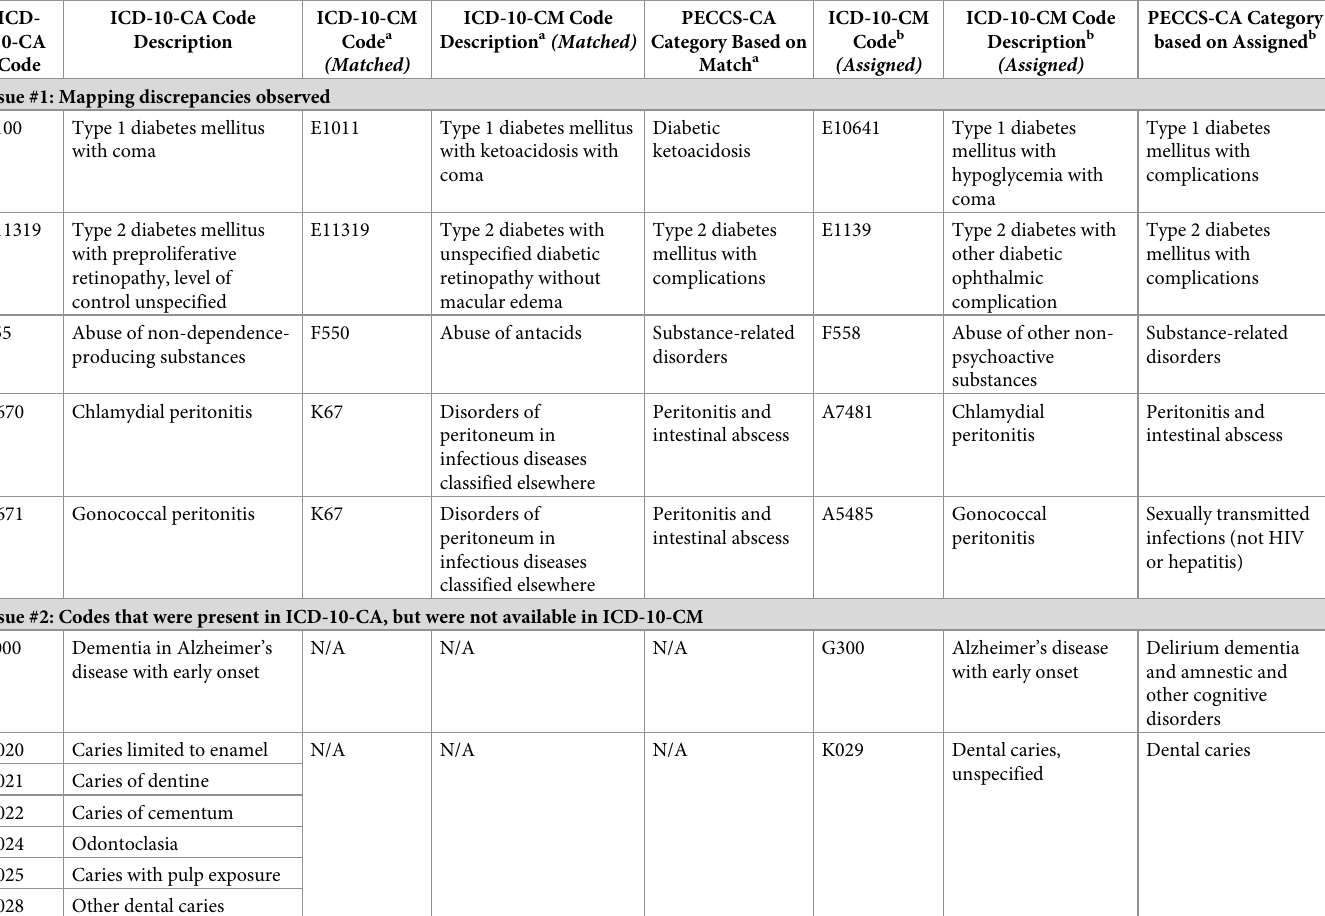
Table 1. Examples of mapping issues and final decisions made in mapping ICD-10-CA codes to ICD-10-CM codes and their corresponding PECCS-CA categories.